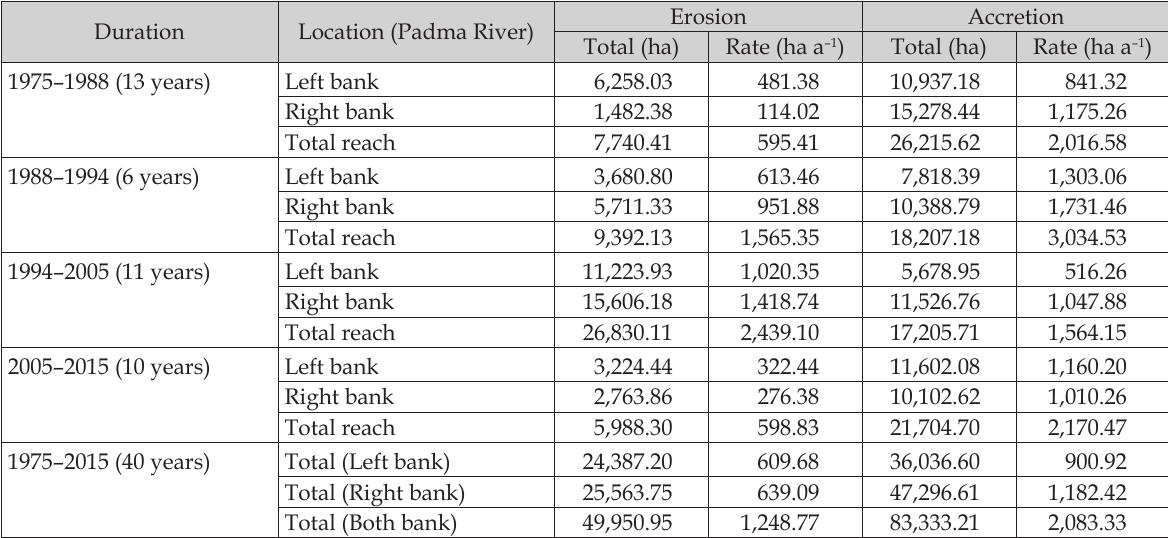
Table 2. Erosion-accretion net along the Padma river.